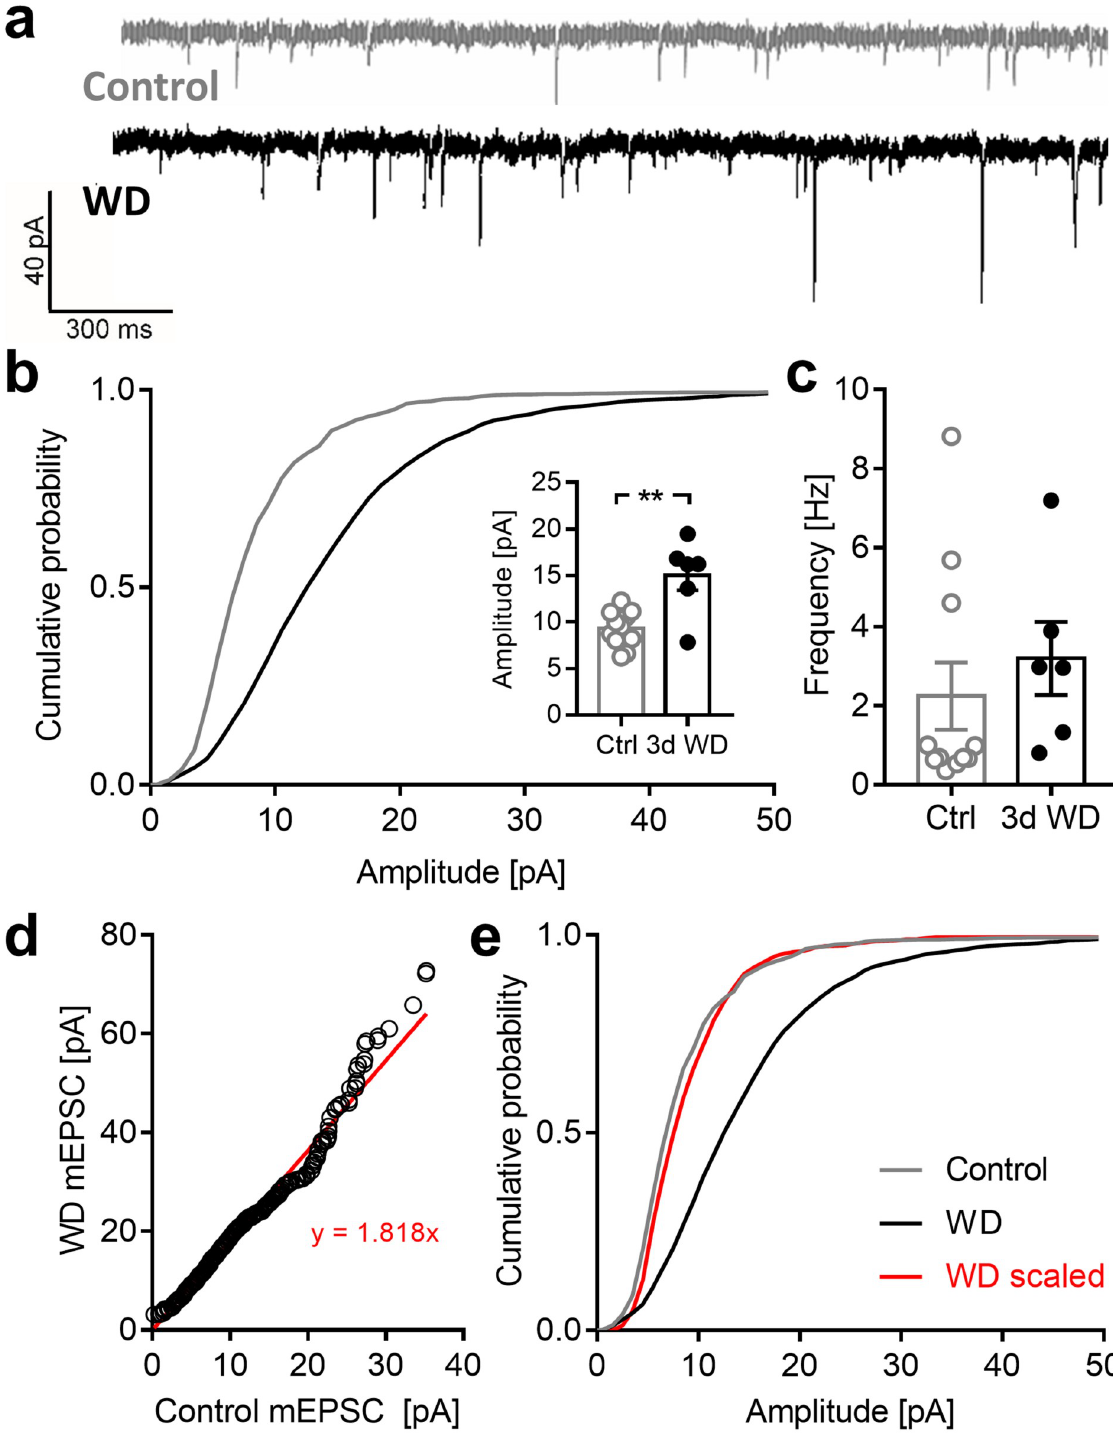
Fig 7. WD cross-modally increases mEPSC amplitudes in V1 layer 4. ( a ) Representative traces of mEPSCs recorded in control mice (n = 4) and 3 d after WD (n = 3) ( b ) Cumulative distribution of all mEPSC amplitudes was right shifted in WD mice compared to control animals. Hence, the mean amplitude of mEPSCs was significantly increased in WD mice. These results suggest that WD induces synaptic plasticity in V1 layer 4. ( c ) Mean frequency of mEPSCs was unaltered after WD. ( d ) Plot of rank ordered mEPSC amplitudes from control and WD mice. The red line represents a linear regression of the data points. ( e ) Cumulative histograms of mEPSC amplitudes. Individual mEPSC amplitudes of WD mice were transformed with the equation y = 1.818x. The distribution of the transformed values is significantly different with the